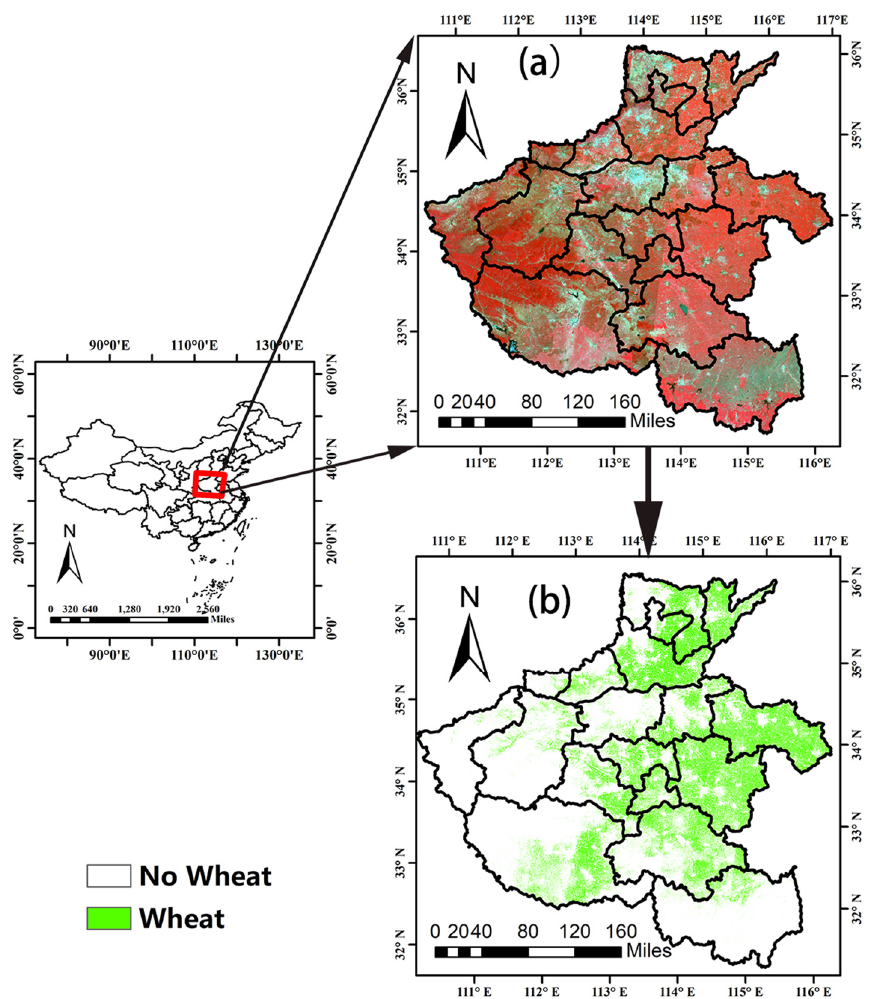
Figure 1. The geographic location of the study area and classification results (The red box on the left is the location of Henan Province. ( a )—false color composite with the MODIS09 data; and ( b )—land classification, green represents the winter wheat region).